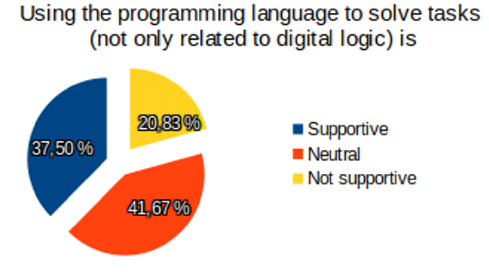
Figure 14. Question related to using programming language during the